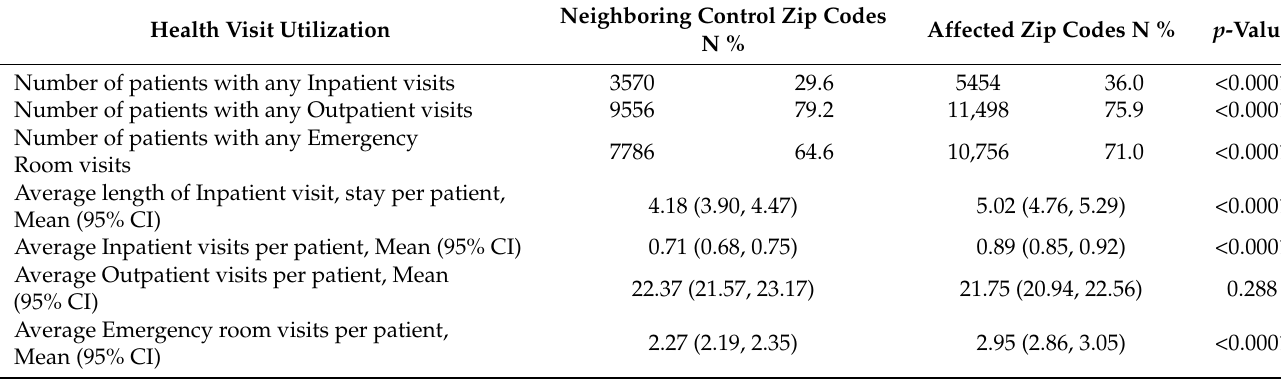
Table 2. Health visit utilization.